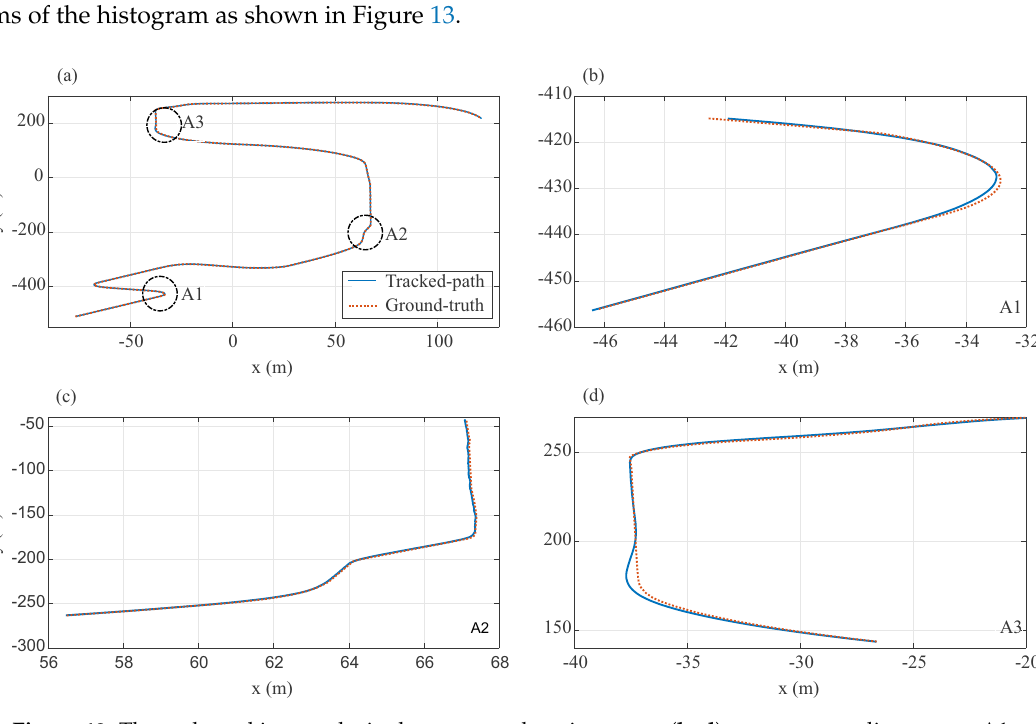
Figure 12. The path tracking results in the structured environment, ( b – d ) are corresponding to part A1, A2, A3 of ( a